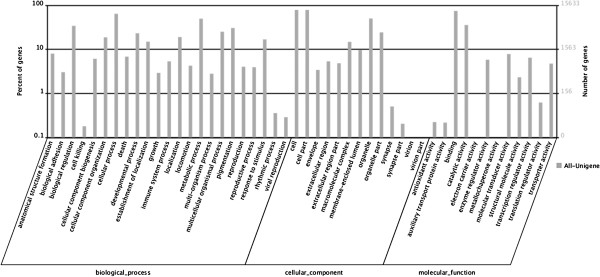
Histogram presentation of Gene Ontology classification. Results are summarized in three main categories: biological process, cellular component, and molecular function. The right y-axis indicates the number of genes in a category. The left y-axis indicates the percentage of a specific category of genes in the main category.